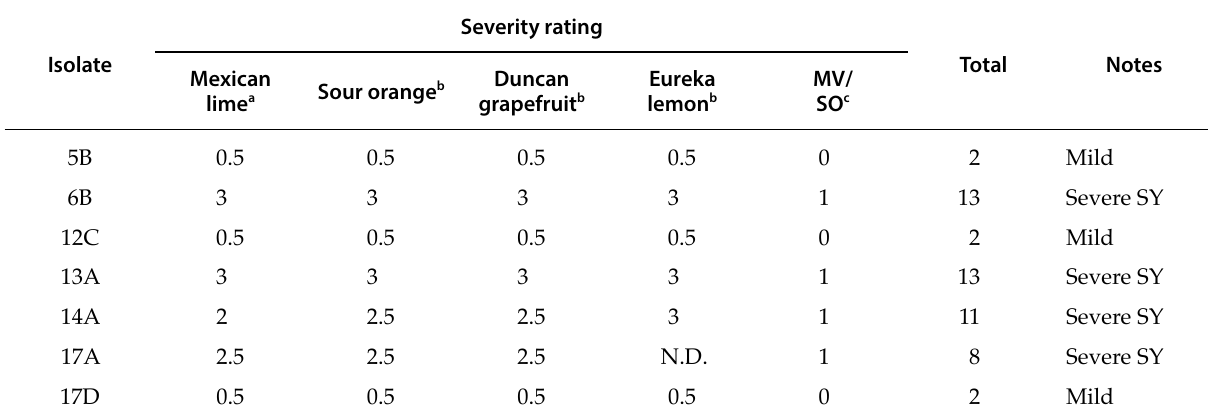
Table 4. Biological characterization of the Citrus tristeza virus isolates from Calabria.